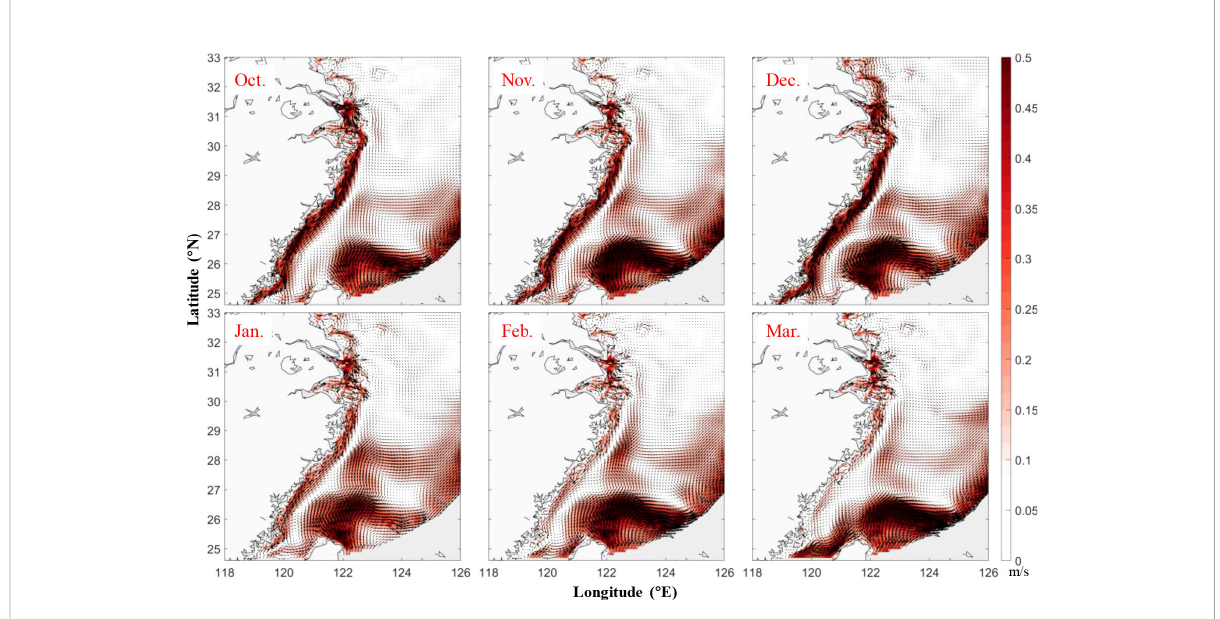
FIGURE 7 Monthly-average surface currents off the Zhejiang-Fujian coast from October 2020 to March 2021, the arrows represent the fl ow direction while color indicates current magnitude.